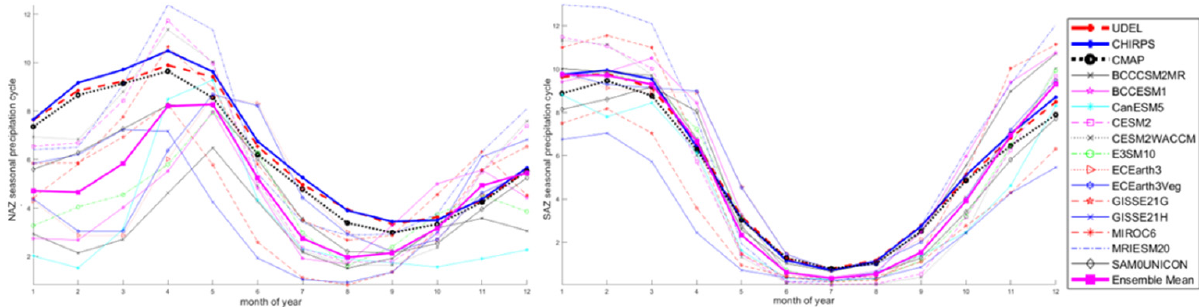
Figure 5. Annual cycle averages for northern Amazon (NAZ—( left ) panel) and southern Amazon (SAZ—( right ) panel) precipitation for 1981–2014 [mm day − 1 ].